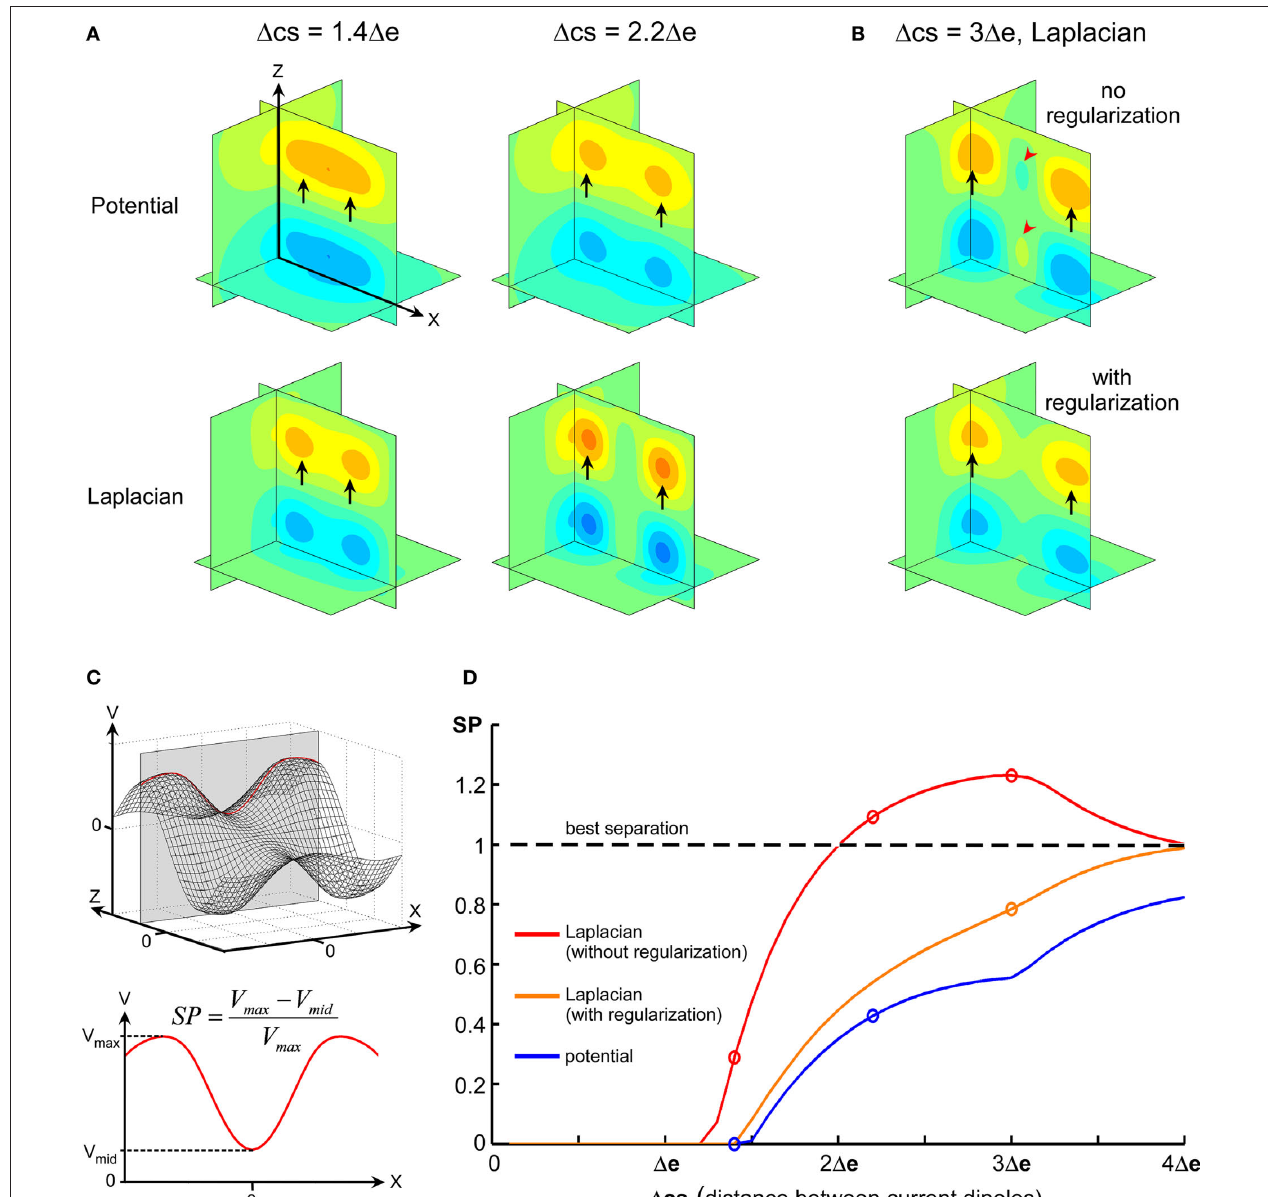
the y = 0 plane (top). The line on which absolute maximum is reached is used. The SP index is defined using the local extrema on the maximum line (bottom). It has a value of 0 when the potential along the line has only one maximum, and is close to 1 for an optimal separation of the maxima. (D) Evolution of SP according to distance between sources ( ∆ ) for raw potential (blue), spatial Laplacian (red), and cs regularized Laplacian (orange). Circles indicate maps drawn in (A,B)